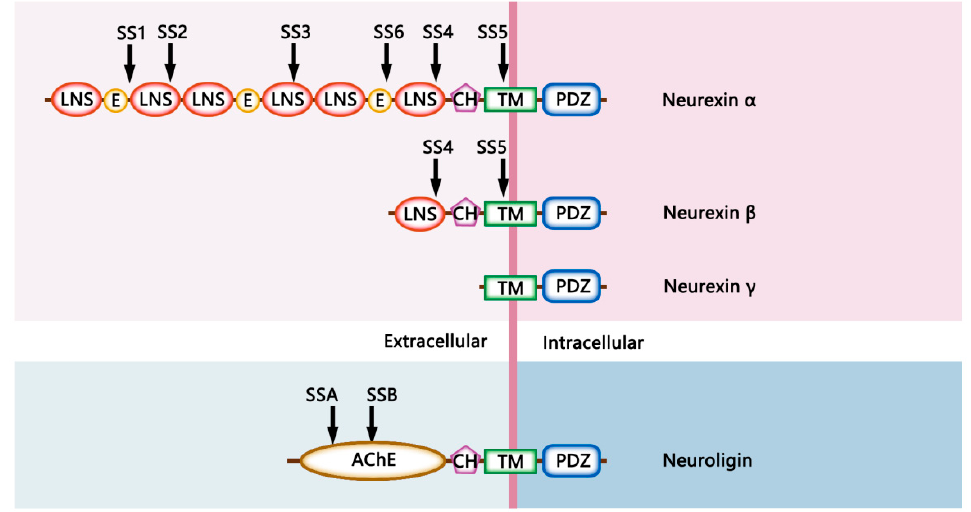
Figure 1. Putative structure of neurexins and neuroligins. Neurexin α consists of six laminin/neurexin/sex-hormone (LNS) globulin domains, three interspersed extracellular epidermal growth factor (EGF)-like repeats, a rigid and highly O-linked glycosylated (CH) stalk, a transmembrane (TM) domain, and a C-terminal PDZ binding motif. Neurexin β lacks any EGF-like regions and only harbors the sixth extracellular LNS domain. Neurexin γ lacks extracellular LNS or EGF-like domains but retains the transmembrane and intracellular tail domains. Full-length Neuroligins are composed of an N-terminal domain, an extracellular globular acetylcholinesterase-like domain (AChE), a CH stalk, a TM domain, and a C-terminal PDZ binding motif. Alternative splice insert sites are indicated as they are referred to in the text.